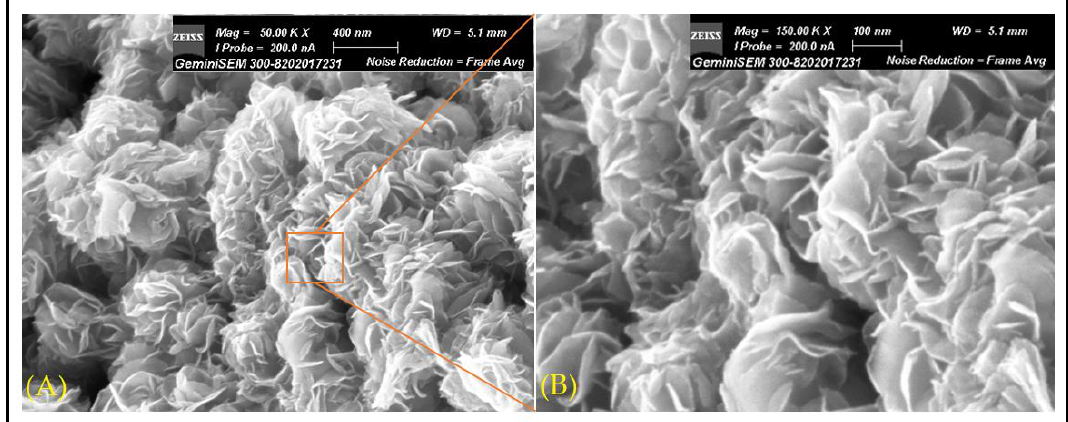
Figure 8. FESEM images 9 wt% g-C 3 N 4 /MoS 2 at magnifications of 400 nm ( A ) and 100 ( B ).